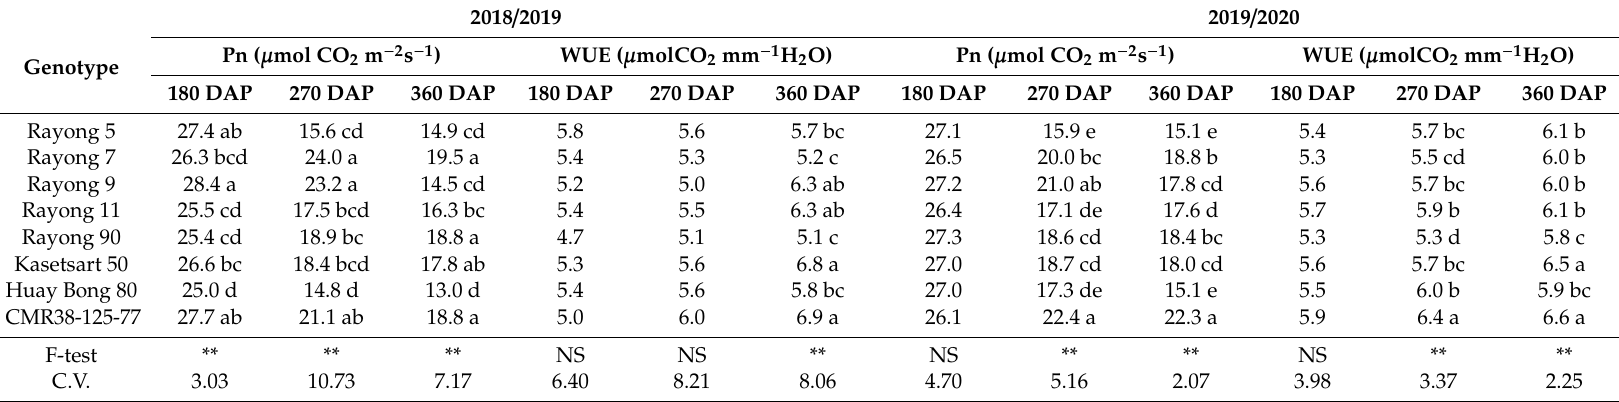
Table 6. Net photo synthesis (Pn) and water use e ffi ciency (WUE) at di ff erent days after planting (DAP) for eight cassava genotypes grown in 2018 / 2019 and 2019 /